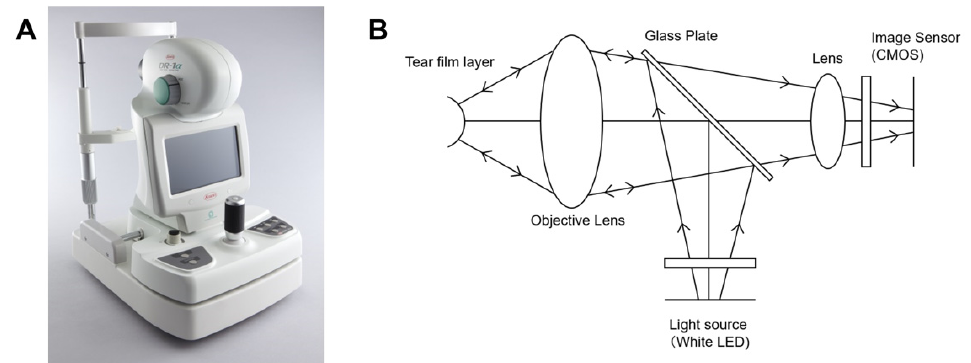
Figure 1. ( A ) The KOWA DR-1a instrument. ( B ) KOWA DR-1a optics. To view light reflected from the tear film layer, the KOWA DR-1 α uses two parallel polarizers so that only the reflected image of the illumination light is captured by the camera, and the external light is not taken into the cam- era.